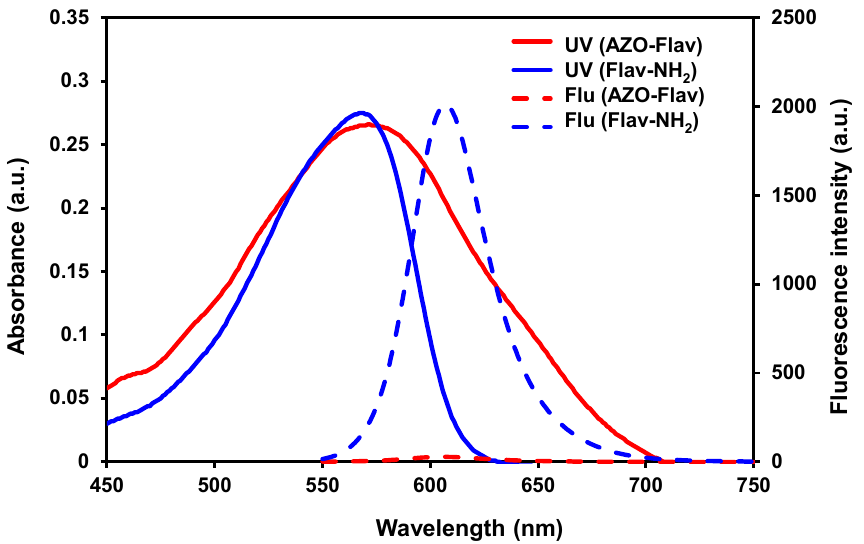
Figure 1. UV-vis-NIR absorption and fluorescence spectra of AZO-Flav and Flav-NH 2 (10 µ M) in 100 mM phosphate buffer (pH 7.4) excited at 540 nm.